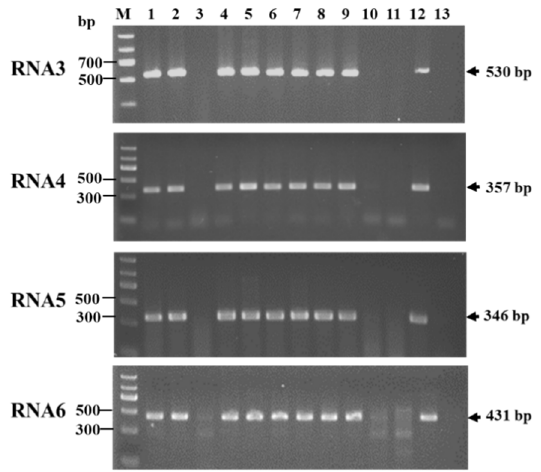
Figure 3. RT-PCR detection of four RNA segments (RNAs 3–6) of jujube yellow mottle-associated virus (JYMaV) in 11 jujube samples from Aksu using four pairs of primers. The sizes of amplicons were indicated on the right of each panel. The sample HZ tested by high-throughput sequencing was used as a positive control (line 12) and a leaf sample from a healthy jujube plant was used as a negative control (line 13). M: DNA marker II .